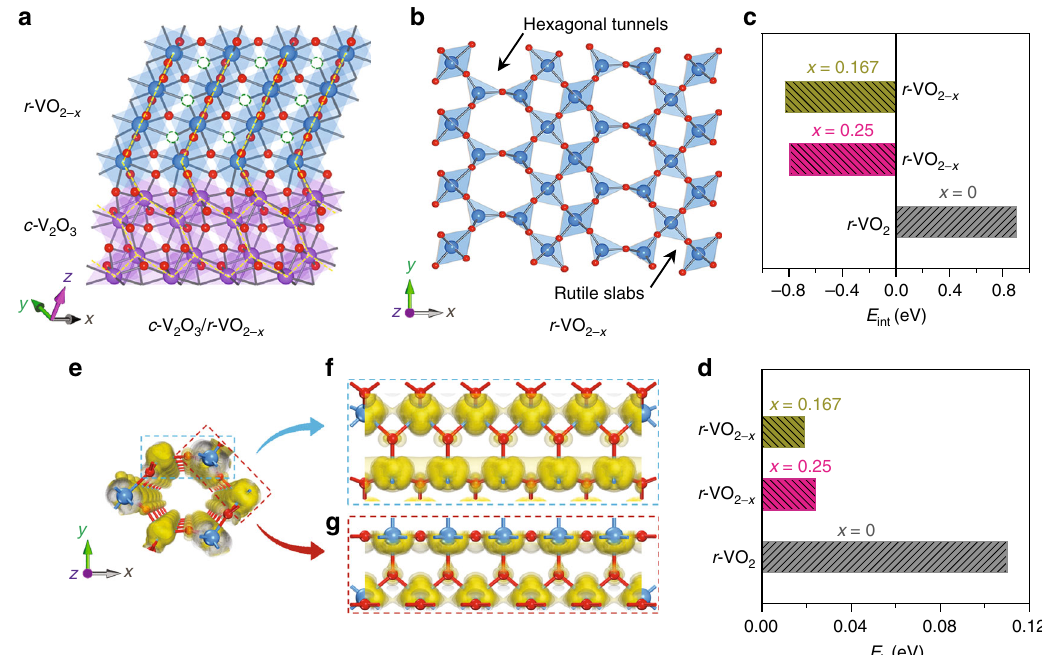
Fig. 1 Structures and DFT computations of vanadium oxides with high electronic conductivity and ionic accessibility. a Atomic schematic illustration for the isomeric vanadium oxides produced by in situ corundum-to-rutile-phase transformation, which consist of corundum-type V 2 O 3 and rutile r -VO 2 − x core/ shell structure. Yellow dashed lines denote the electron transport pathways along short V – V bonds. Purple and blue balls represent vanadium atoms in corundum-type V 2 O 3 and rutile-type VO 2 − x , red and white ones denote oxygen atoms and ordered oxygen vacancies. b Representative atomic structure of the r -VO 2 − x layer with ordered 1D quasi-hexagonal tunnels along z -axis. c , d Comparison of intercalation energy ( E int ) ( c ) and energy barrier ( E b ) ( d ) for Na + in the tunnels of the r -VO r -VO x = 0.25 and 0.167. e – g Electron density distributions of the projected orbitals for the quasi-hexagonal 2 and 2 − x with tunnel ( e ) and the V-O walls of quasi-hexagonal tunnel ( f ) and rutile slab ( g